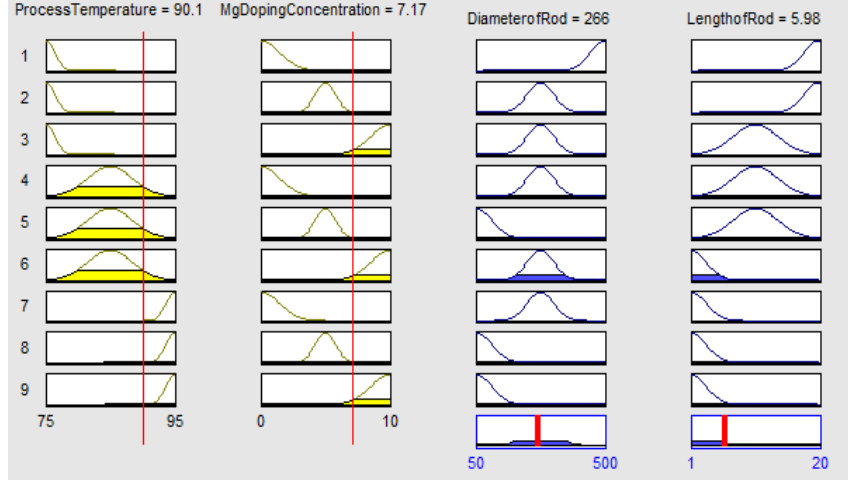
Fig. 5. Rule Viewer for Crisp Value